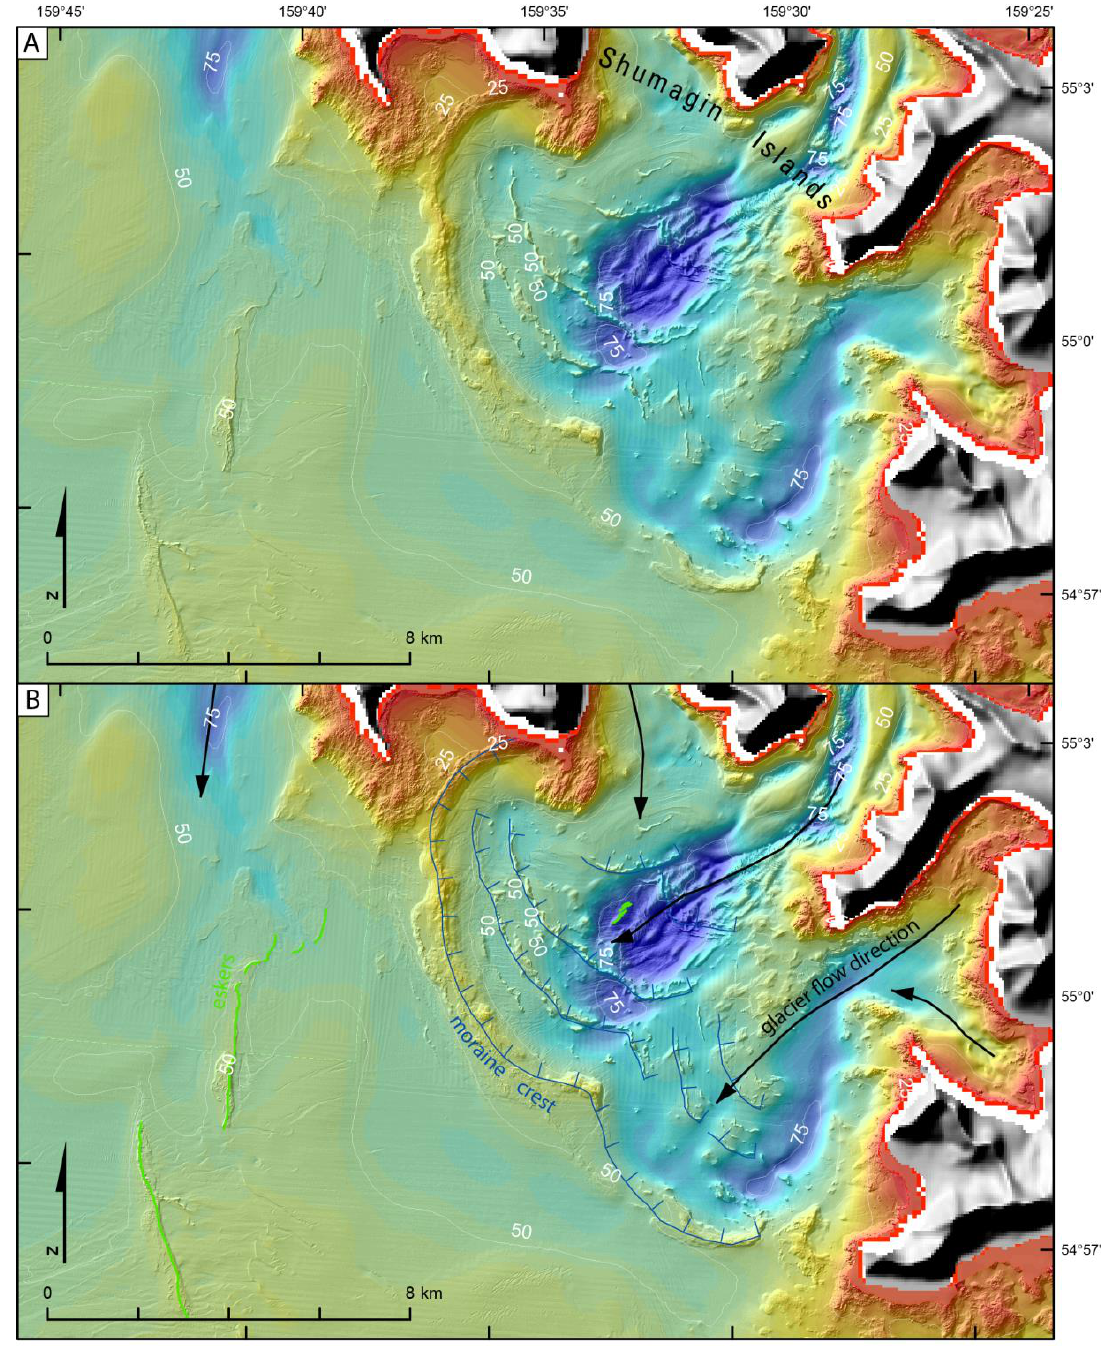
Figure 10. Glacial features mapped on the west side of the Shumagin Islands. ( A ) Bathymetry shown without interpretation, and ( B ) bathymetry shown with interpretation. Location of map is shown on Figure 5 and symbology is the same as Figure 5, but the color ramp is different, with the labelled contours indicating depth. These images show glacial lineations in the central part of the trough, the moraine crests and then some probable eskers (green lines) distal to the moraine crests.